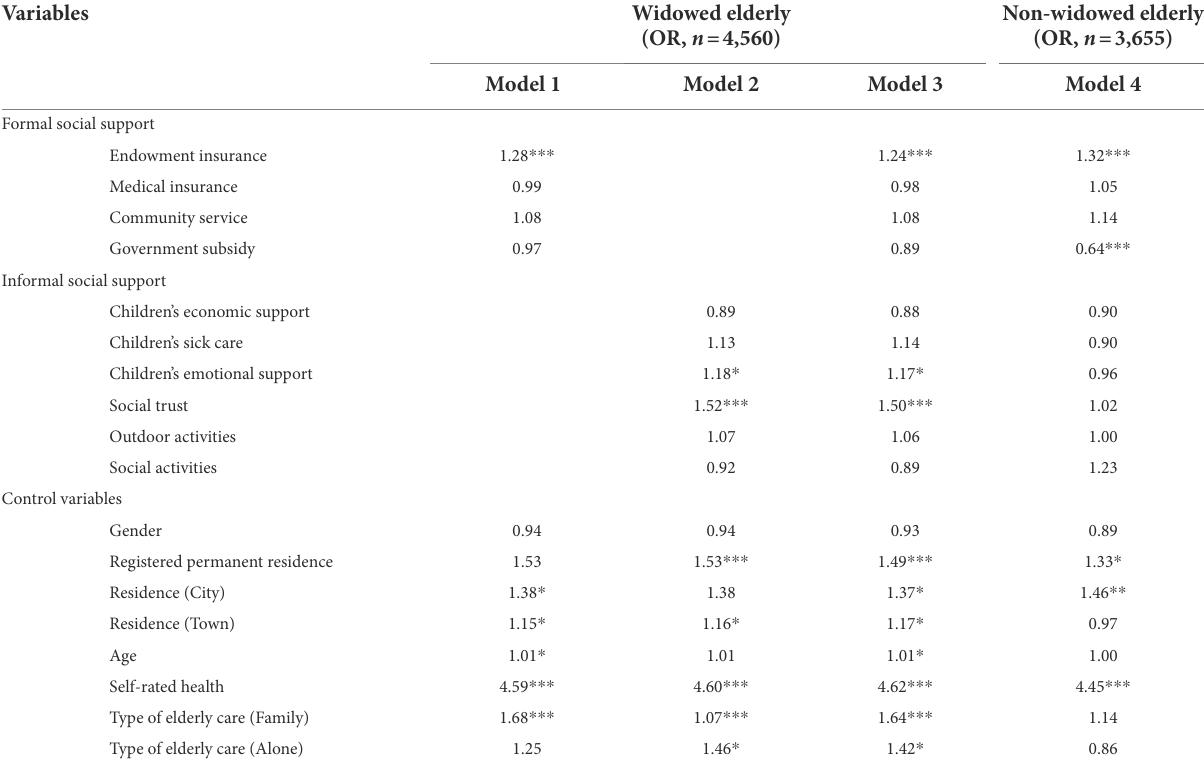
TABLE 5 Impact of social support on the life satisfaction of widowed vs. non-widowed elders.